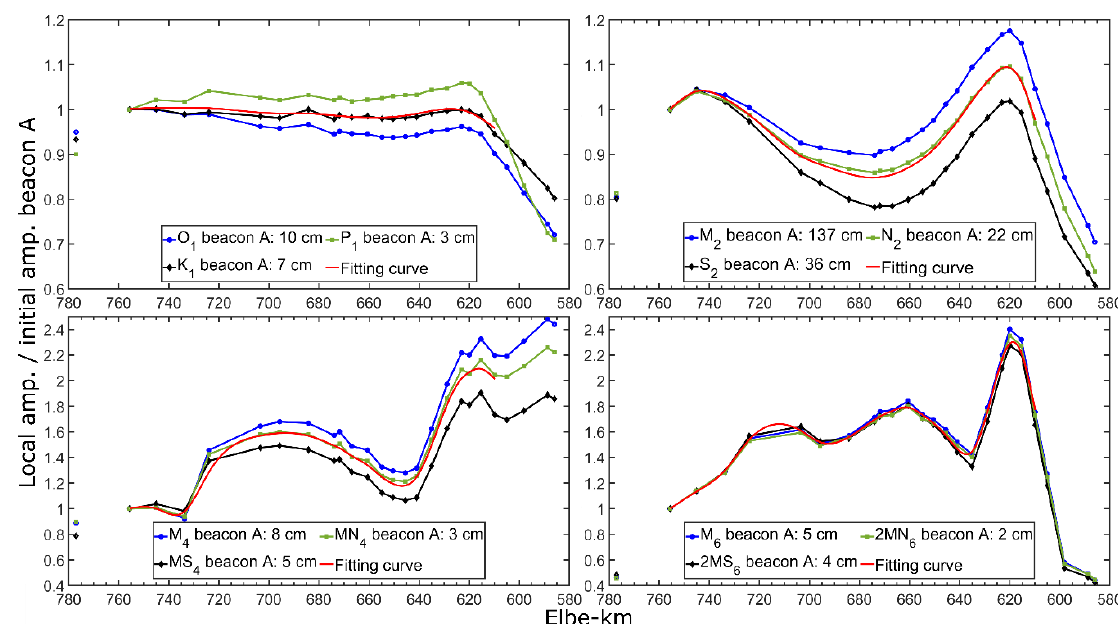
Figure 3. Typical forms of diurnal, semidiurnal, quarter-diurnal and sixth-diurnal tides in the Elbe estuary normalised to incoming amplitudes measured at beacon A. Separated datum points show gauge Helgoland in the German Bight. Harmonic analysis method of least squares (HAMELS) conducted without compound tides over a nodal cycle beginning at 1 January 2000 12:00:00 considering nodal corrections.